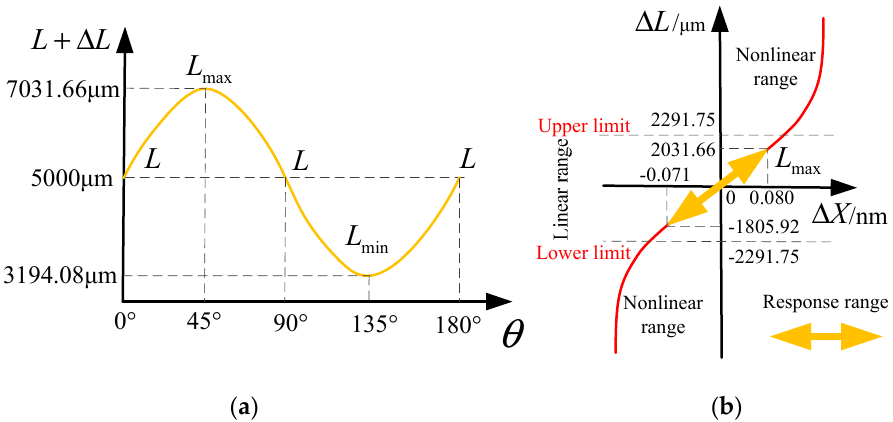
Figure 19. Dynamic response of the MOEMS-RG ( a ) The relationship curve of displacement of the sensitive silicon membrane ∆ L and rotation angle of the resonator gyroscope. ( b ) The relationship curve of the resonant wavelength change ∆ X and input signal ∆ L .